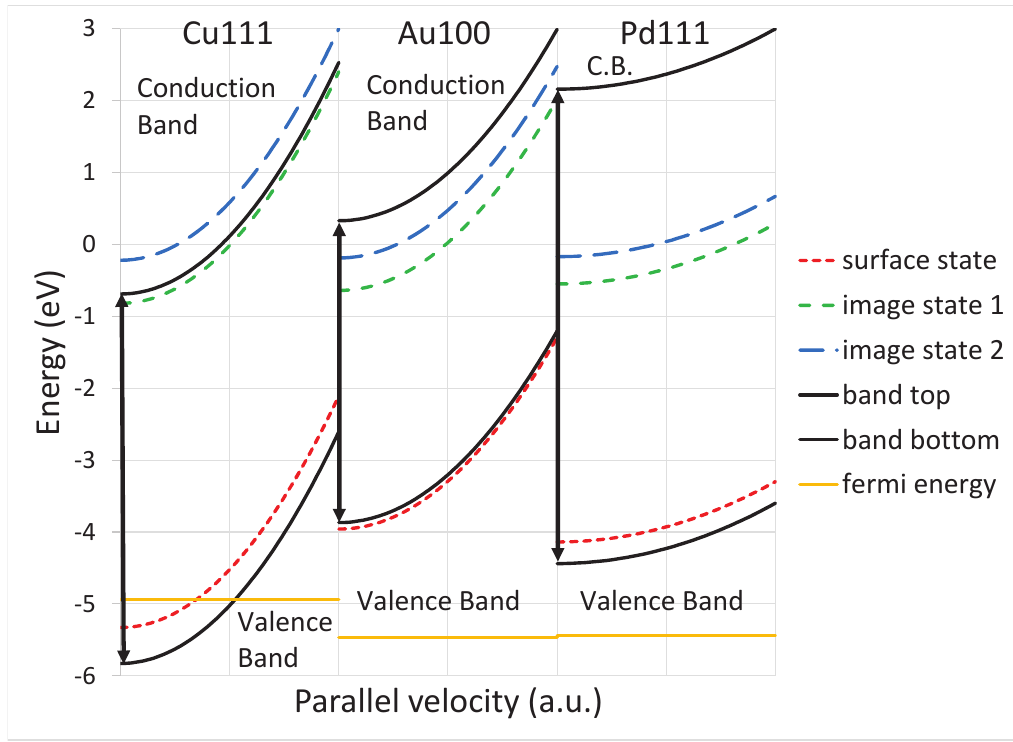
Figure 7. Dispersion relations for flat Cu(111), Au(100) and Pd(111) substrates assuming a translationally invariant surface and an electron velocity component in the surface plane. We show the Fermi energies only for